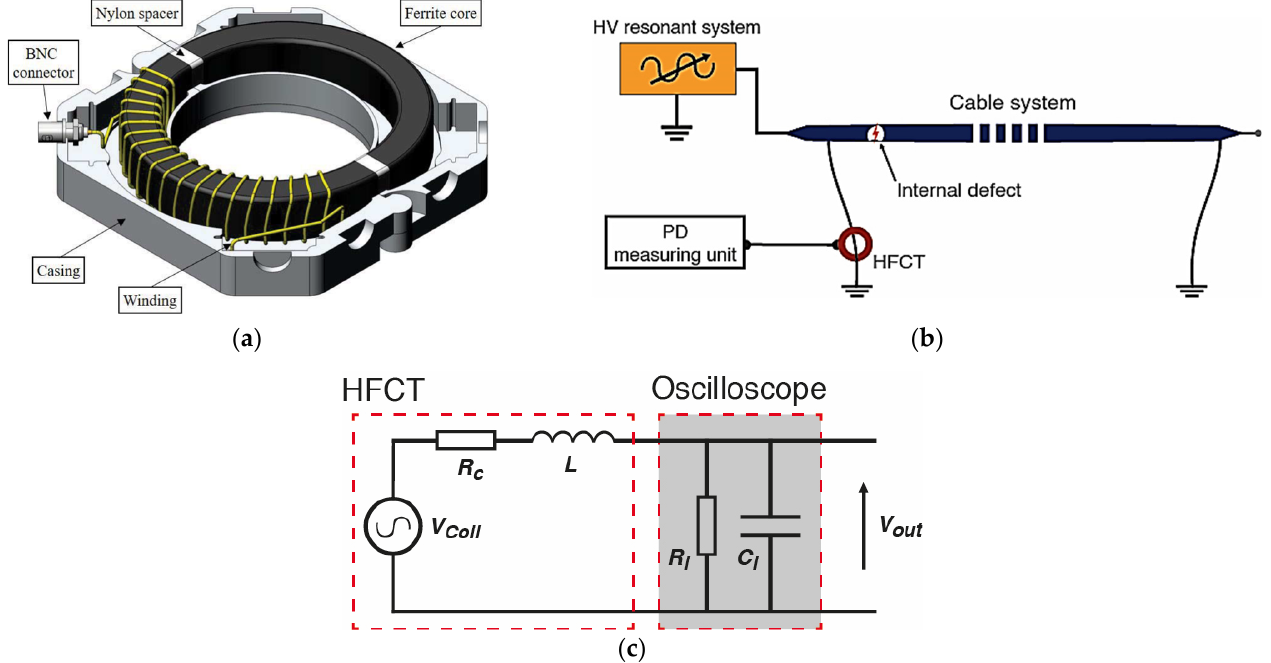
Figure 5. ( a ) HFCT model (20 winding turns) with the top part of the casing removed [74], ( b ) HFCT sensor placed in a ground conductor for PD measurement in the cable system, ( c ) the equivalent circuit model of the HFCT sensor.